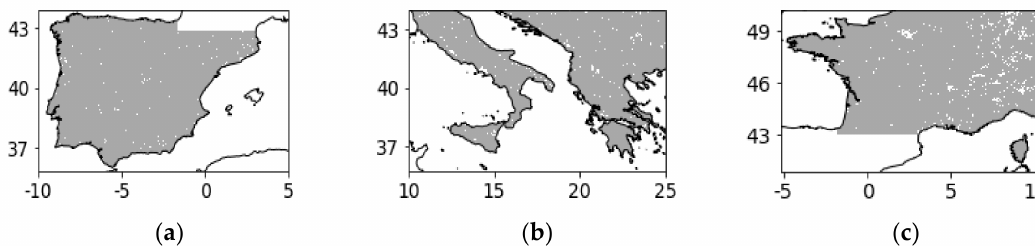
Figure 1. Study areas: ( a ) Iberian Peninsula, IB; ( b ) Eastern Mediterranean, EM; ( c ) Western Europe, WE. The study areas are: Iberian Peninsula (hereafter IB, left panel); Eastern Mediterranean (hereafter EM, centre panel); and Western Europe (hereafter WE, right panel). The study period comprised the years between 2001 and 2019, which are covered by MODIS